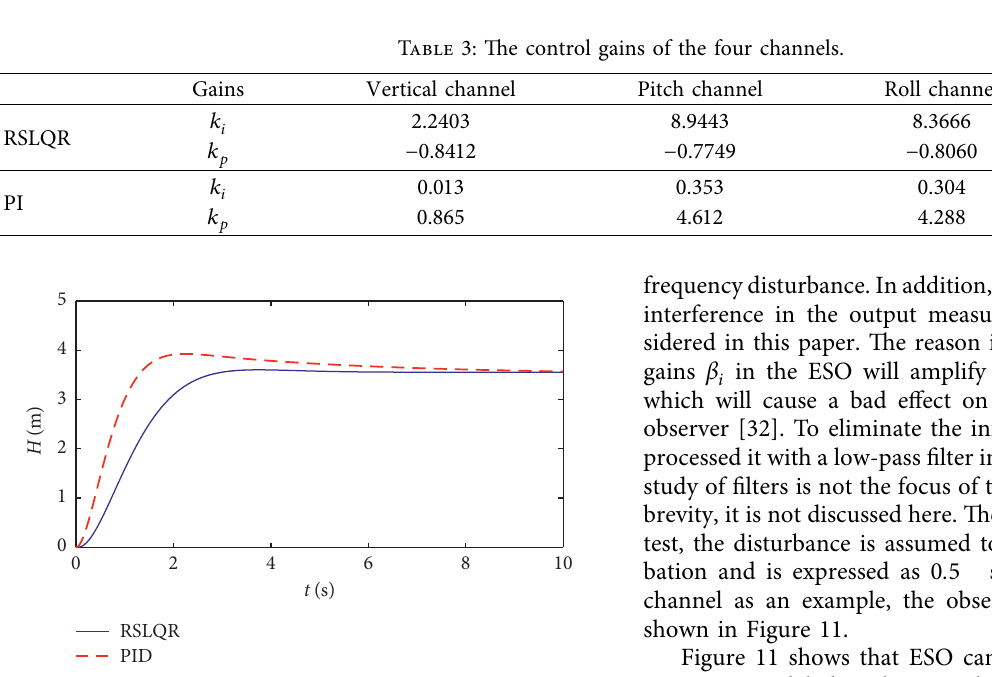
Figure 9: Comparison results of height response.